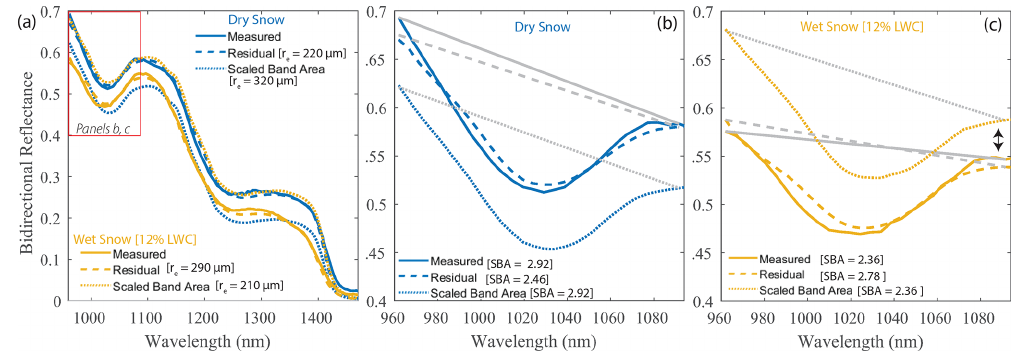
Figure 12. Effective grain radius ( r e ) retrieval comparison between the residual and scaled band area methods using the interstitial sphere model. (a) An example of measured spectra from a dry and wet snow sample and the corresponding retrieved simulated spectra using the residual and scaled band area methods. (b) Dry snow spectra from (a) including the continuum lines, shown in gray, over the absorption feature. (c) Wet snow spectra from (a) including the continuum lines over the absorption feature, shown in